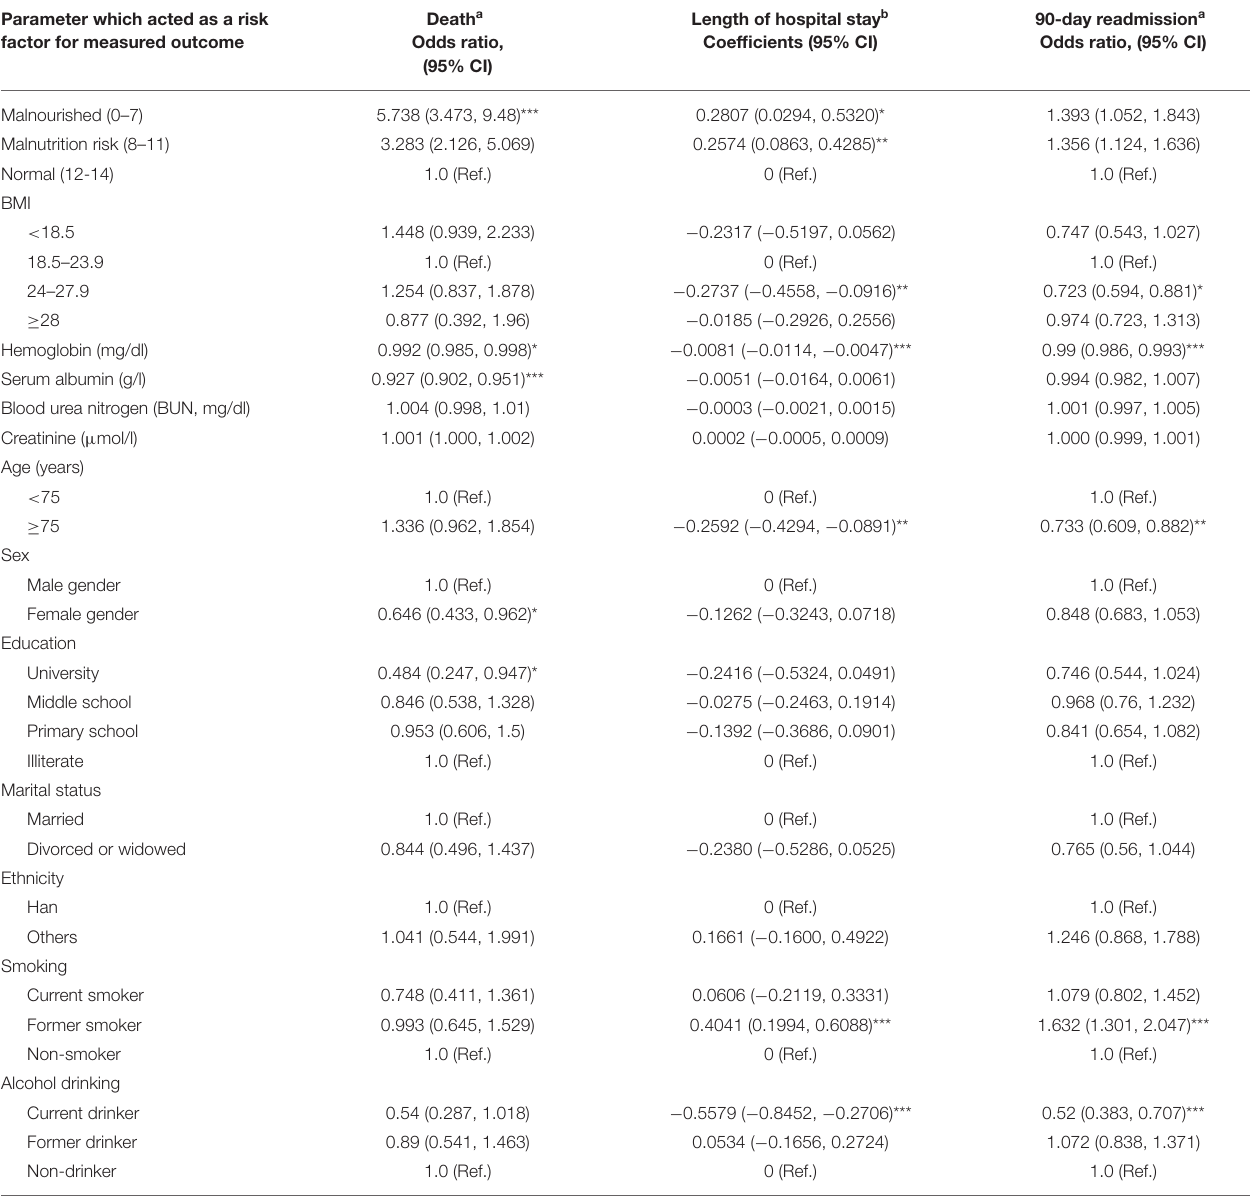
TABLE 3 | Prevalence of measured outcomes in relation to nutritional status and clinical parameters analyzed. Parameter which acted as a risk factor for measured